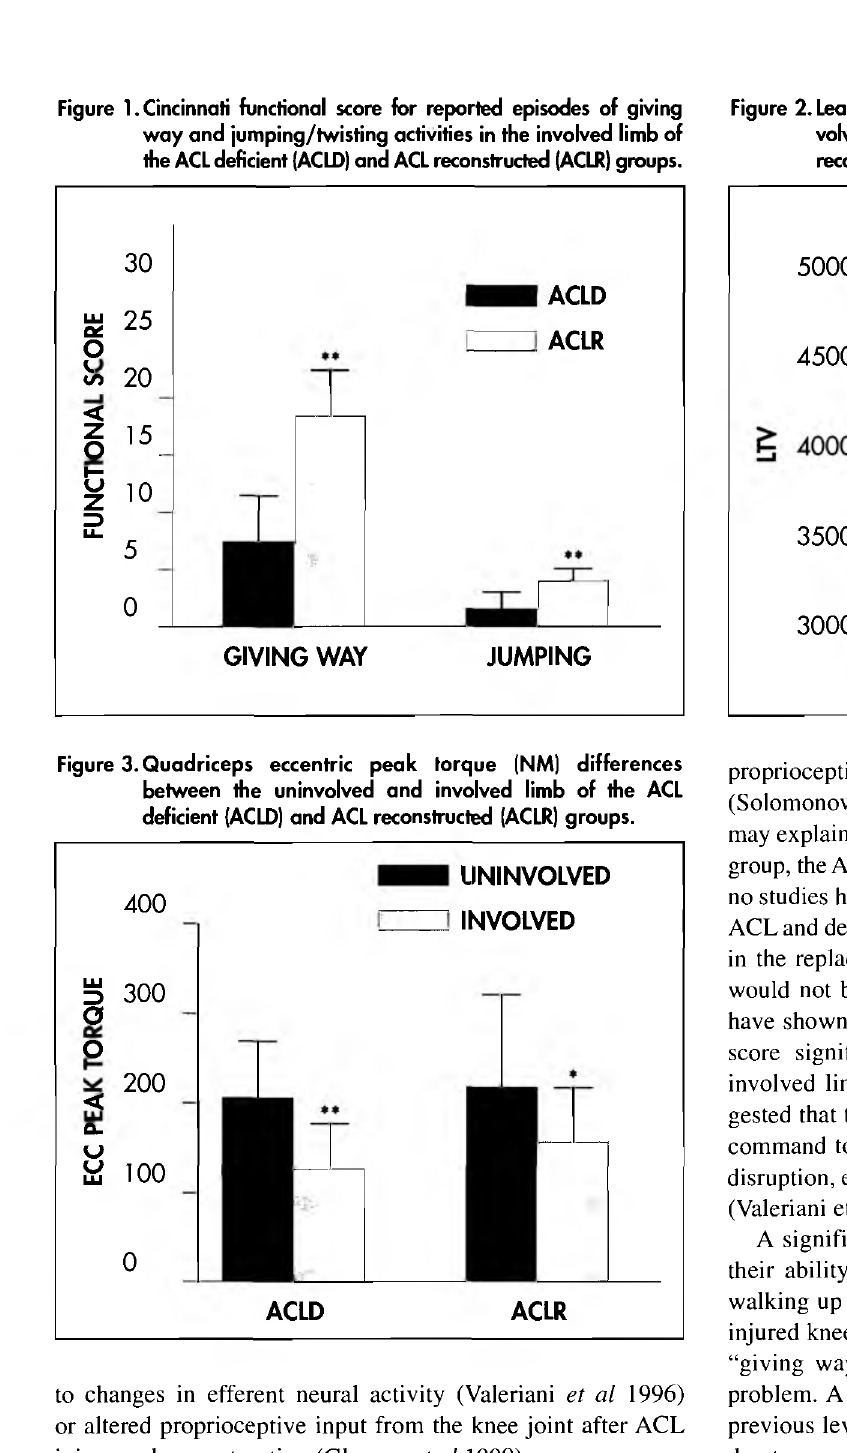
Figure 1. Cincinnati functional score for reported episodes of giving way and jumping/twisting activities in the involved limb of the ACL deficient (ACLD) and ACL reconstructed (ACLR) groups.